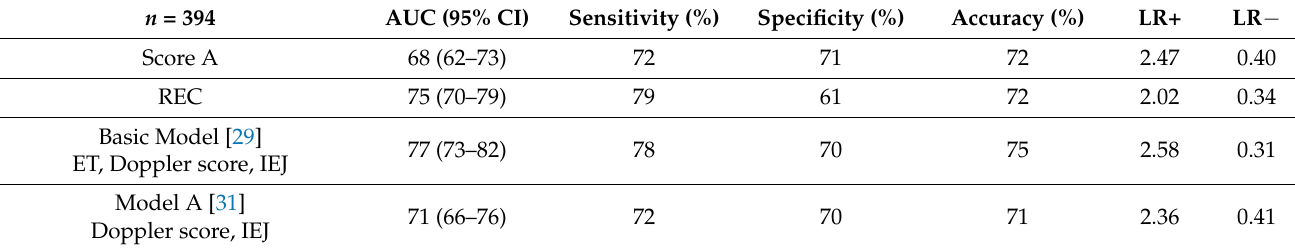
Table 4. Scoring systems performance for the prediction of atypia or endometrial cancer (Area Under the Curve—AUC, LR+—positive likelihood ratio, LR − —negative likelihood ratio, endometrial thickness—ET, interrupted endomyometrial